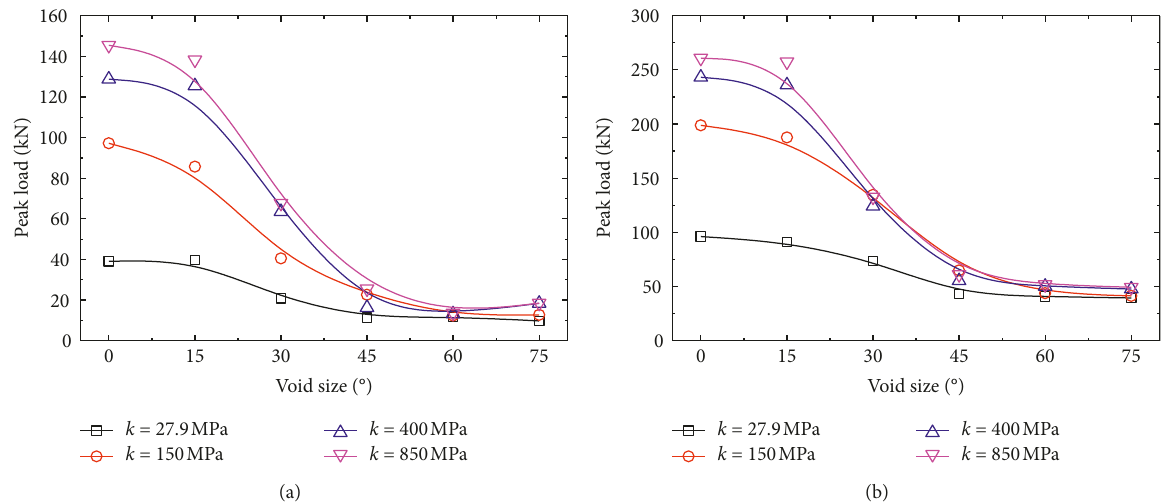
Figure 10: Peak load-crown void size relationship curve of the lining. (a) 45 ° oblique loading. (b) Horizontal loading.